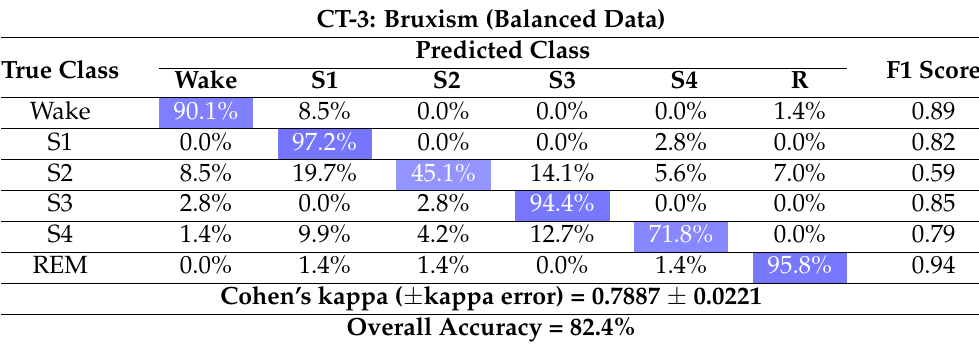
Table 14. Confusion matrix corresponding to sleep stage classification of bruxism patients with balanced data using the EBT classifier with 10-fold CV.